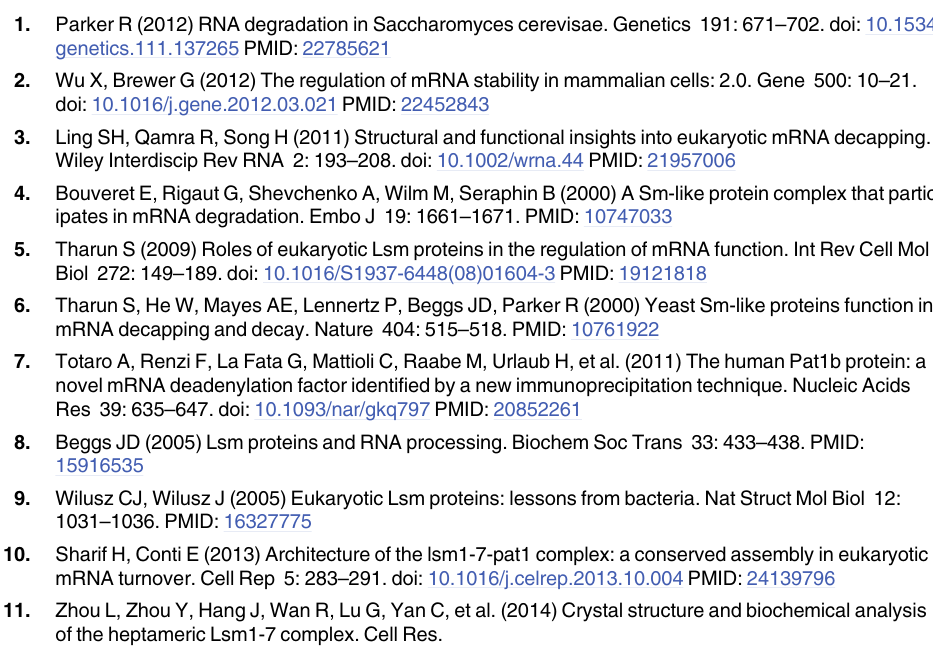
S3 Fig. Truncation of the N-terminal and middle regions of the C-terminal extension of Lsm1 have moderate effects on mRNA decay. RNA isolated from lsm1 Δ cells expressing wild type or mutant alleles ( lsm1-36 , lsm1-37 and lsm1-38 ) of LSM1 were subjected to Northern analysis to reveal the MFA2pG mRNA and the poly(G) fragments. A schematic diagram show- ing the three deletions studied and the phosphorimage of the Northern blot are shown in the upper and lower panels respectively. Poly(G) fragment levels were approximated and presented as described in the legend for Fig 2. S4 Fig. FLAG-Lsm1-27 interacts with the C-terminal extension peptide in pat1 Δ cells. Lysates from FLAG-lsm1-27 and FLAG-lsm1-27 pat1 Δ strains that do or do not express His- tagged wild type Lsm1 C-terminal extension peptide and proteins pulled down from such lysates using the Ni-NTA matrix were subjected to Western analysis using anti-FLAG antibod-